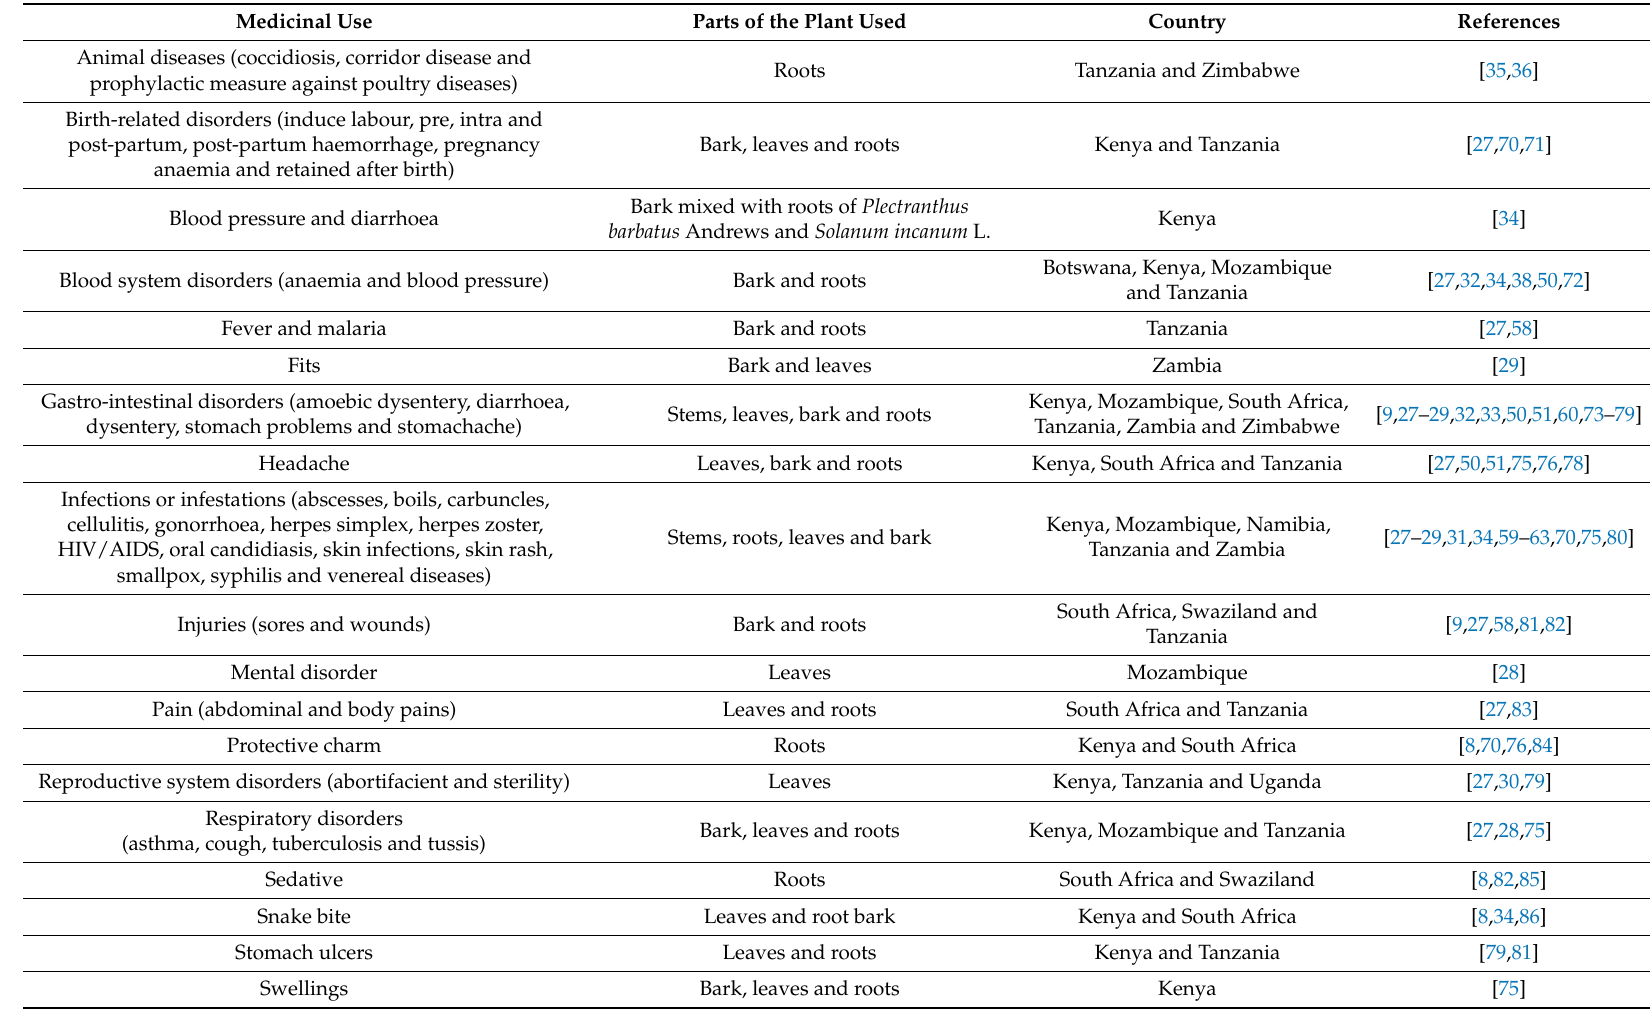
Table 1. Medicinal uses of Lannea schweinfurthii in south, central and east Africa. Medicinal Use Parts of the Plant Used